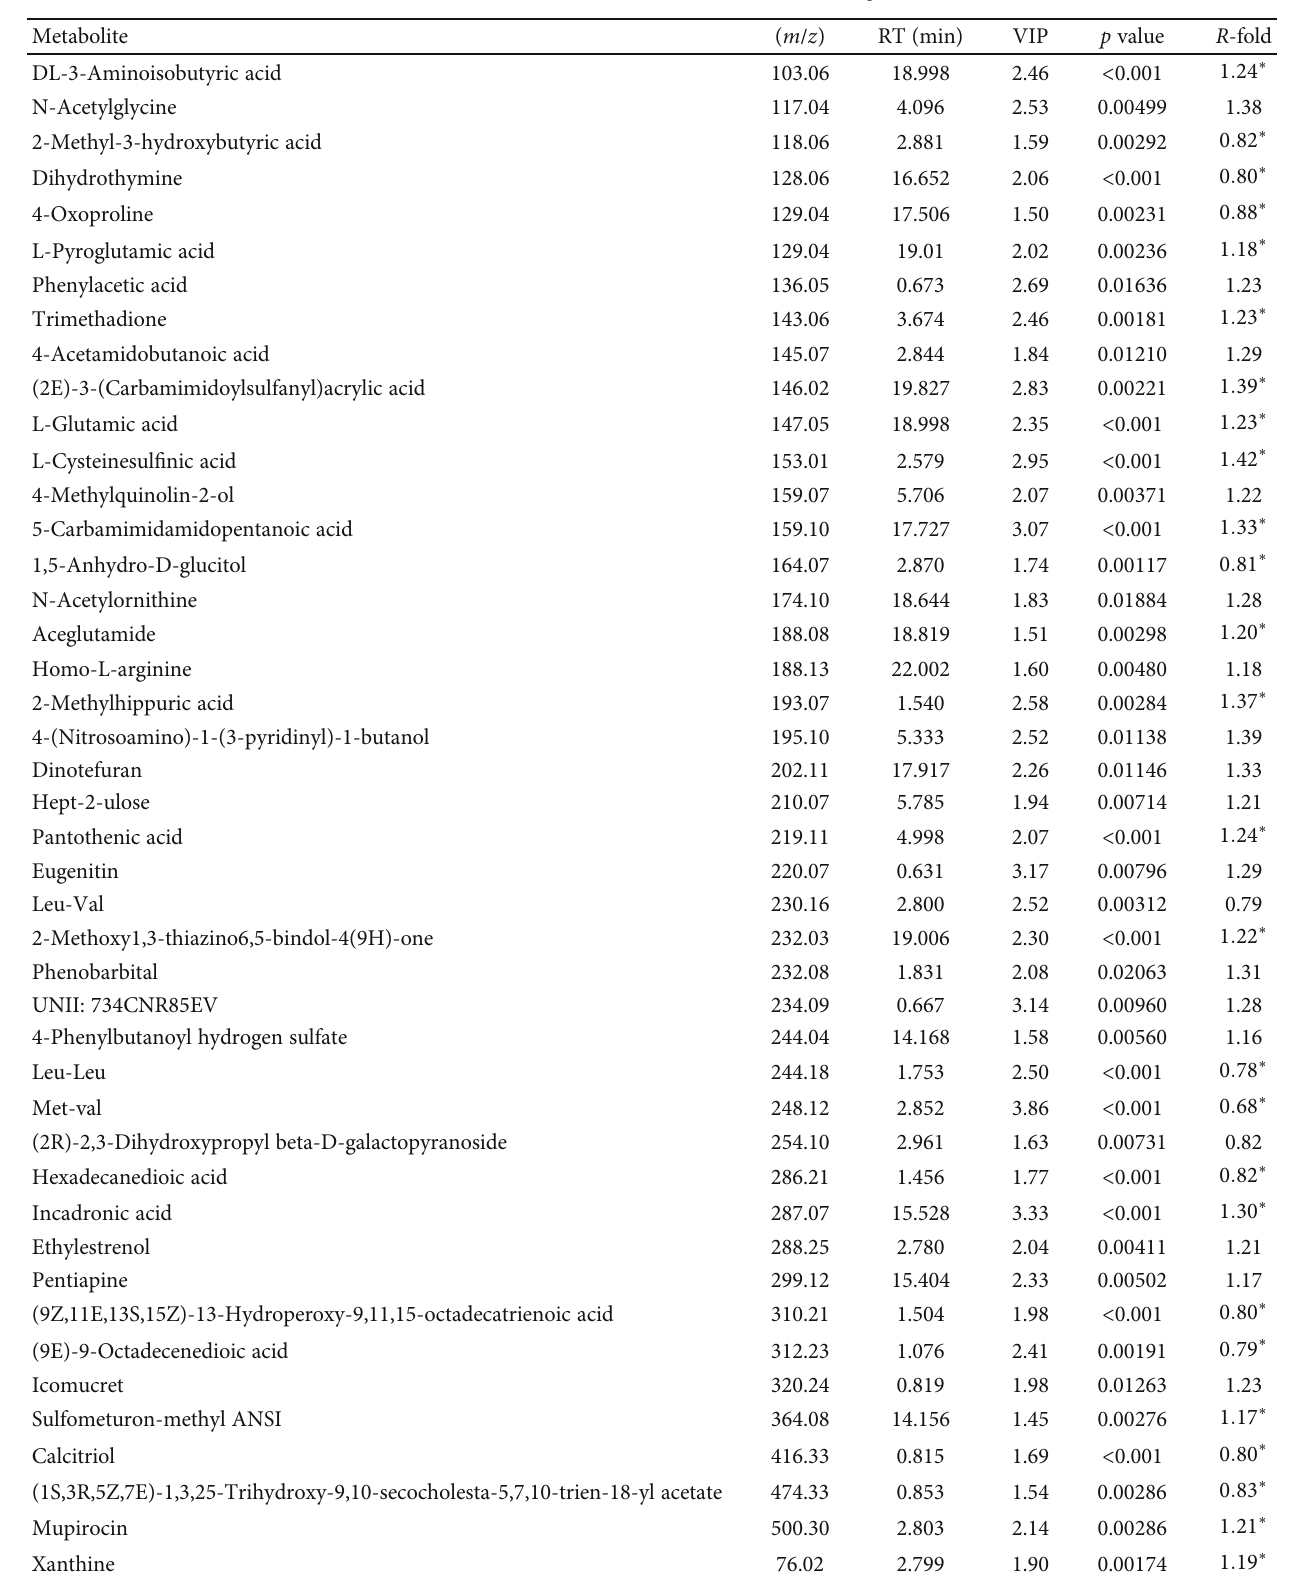
Table 2: The 44 di ff erential metabolites associated with the risk of gestational